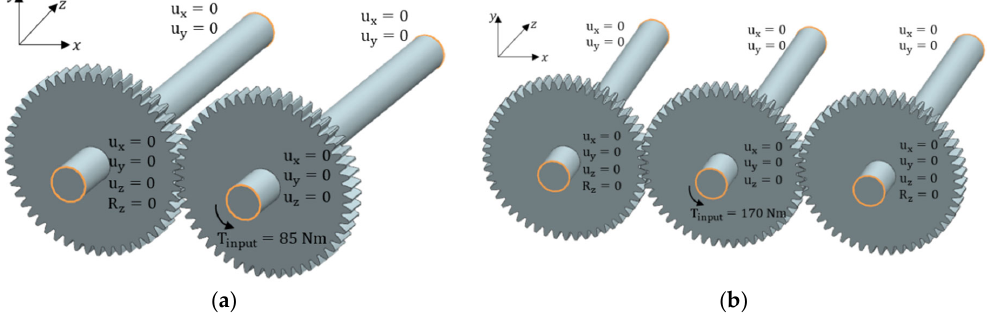
Figure 12. ( a ) Mesh structure on the gear. ( b ) Torque split model contact regions. 8- The X and Y directions are fixed at the endpoints of the shaft to provide support on the shafts. At the end where torque is applied to the pinion, RX, RY, and RZ are released in Figure 13. One of both ends of the shaft is released in the Z direction. In the driven gears, RZ is fixed at the end in the direction of torque flow to simulate the torque of resistance. RX and RY are released. One of both ends of the shaft is released in the Z direction. X and Y coordinates represent the lateral plane and can be assumed perpendicular to the shaft axis. The shaft lays along the Z direction.